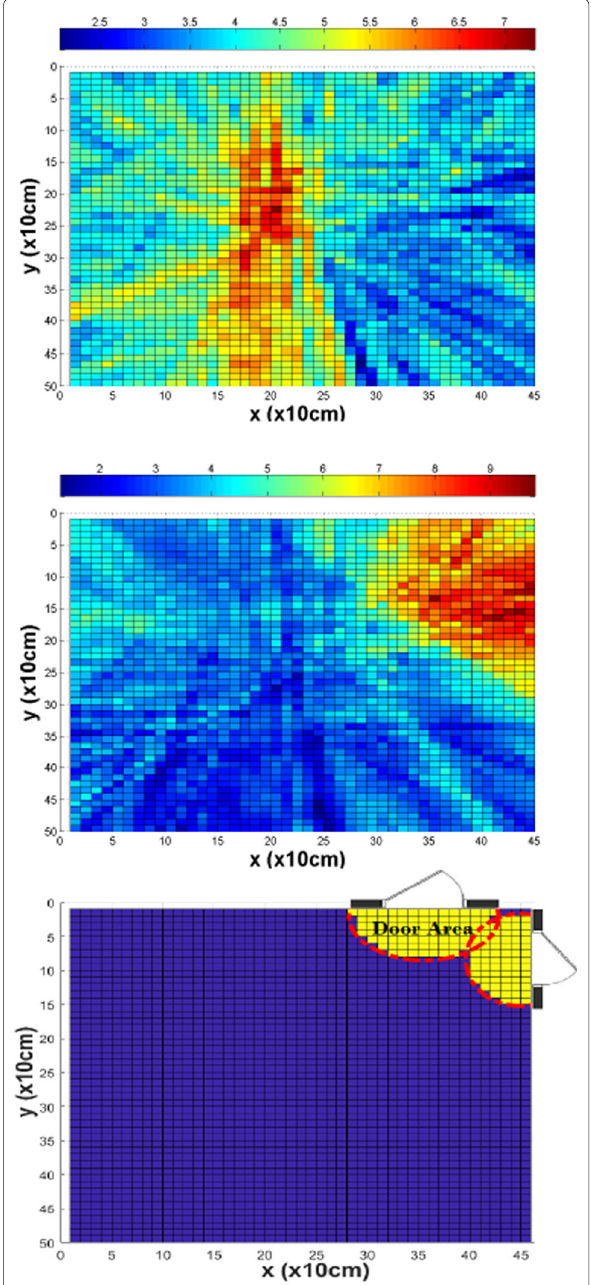
Fig. 5 Motivation for the SRP-based feature (the acoustic maps are shown in 2D, obtained after summing SRP-PHAT values over the z -axis). Top: acoustic map example for speech inside the living room of the apartment of Fig. 1. Middle: acoustic map example for speech outside the living room. Bottom: living room door area (two doors) employed in the SRP-based feature computation (8) for this